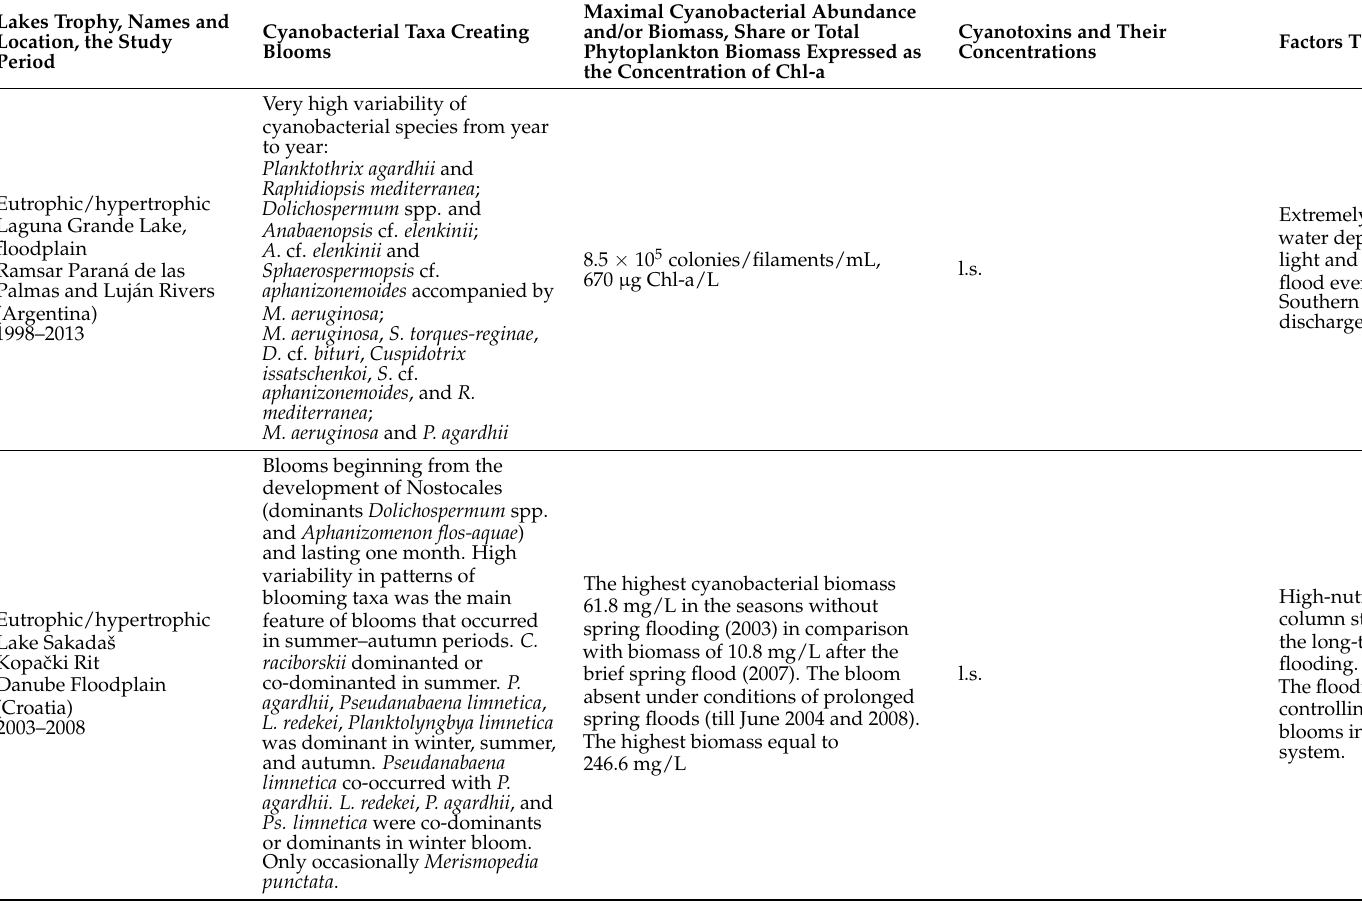
Table 1. Cyanobacterial blooms in floodplain lakes (the selected